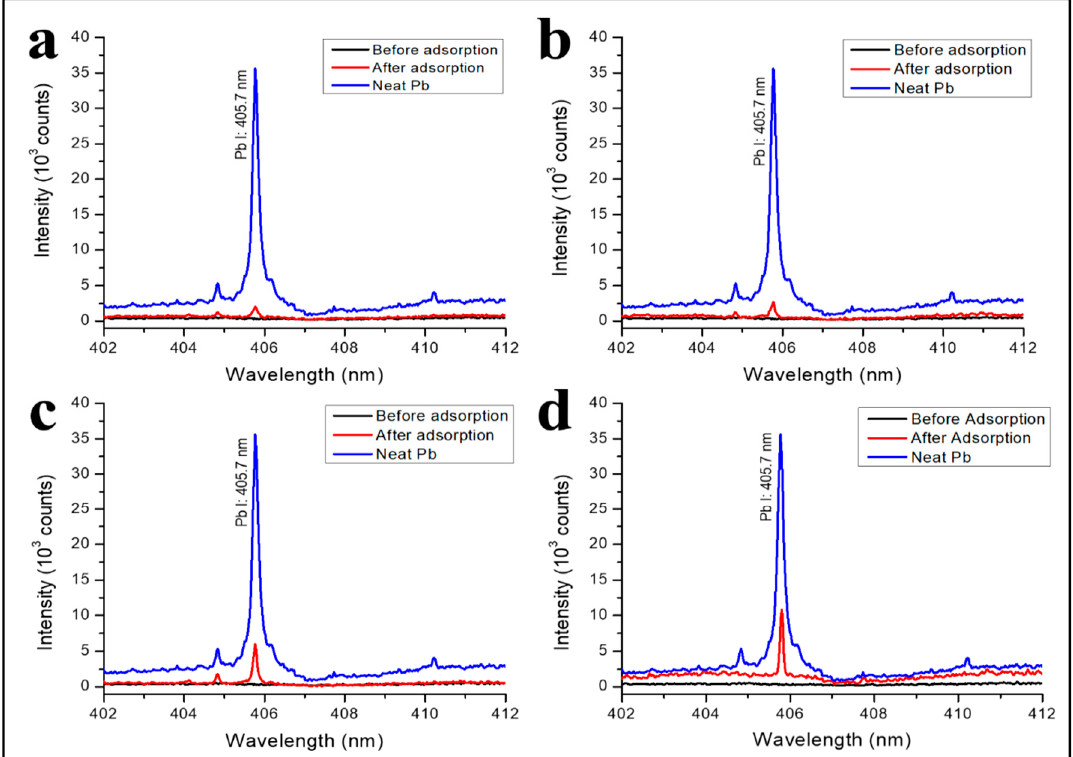
Figure 7. LIBS spectra of ( a ) CA; ( b ) CA–PU15; ( c ) CA–PU30; and ( d ) CA–PU45 before and after the adsorption, in comparison with the neat Pb spectra.